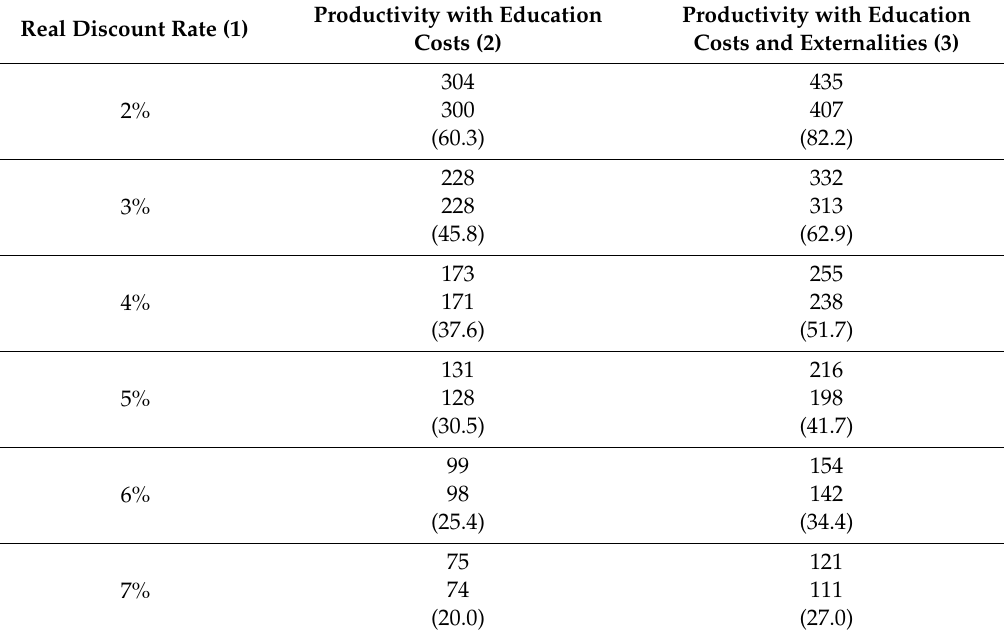
Table 3. U.S. High School Graduation Estimates: Alternative Discount Rates and Specifcations, Point Estimates and Monte Carlo Means (and Standard Deviations) in 1000s of 2019